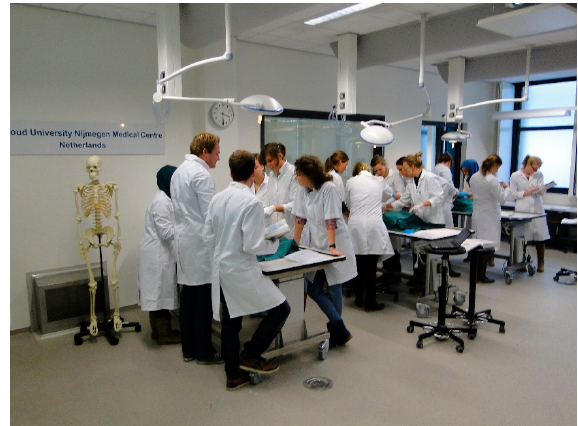
Figure 2. Teaching in TR-2 with air flowing into the room from the ceiling through fabric ducts and extraction vent system in the wall on the left (behind skeleton).